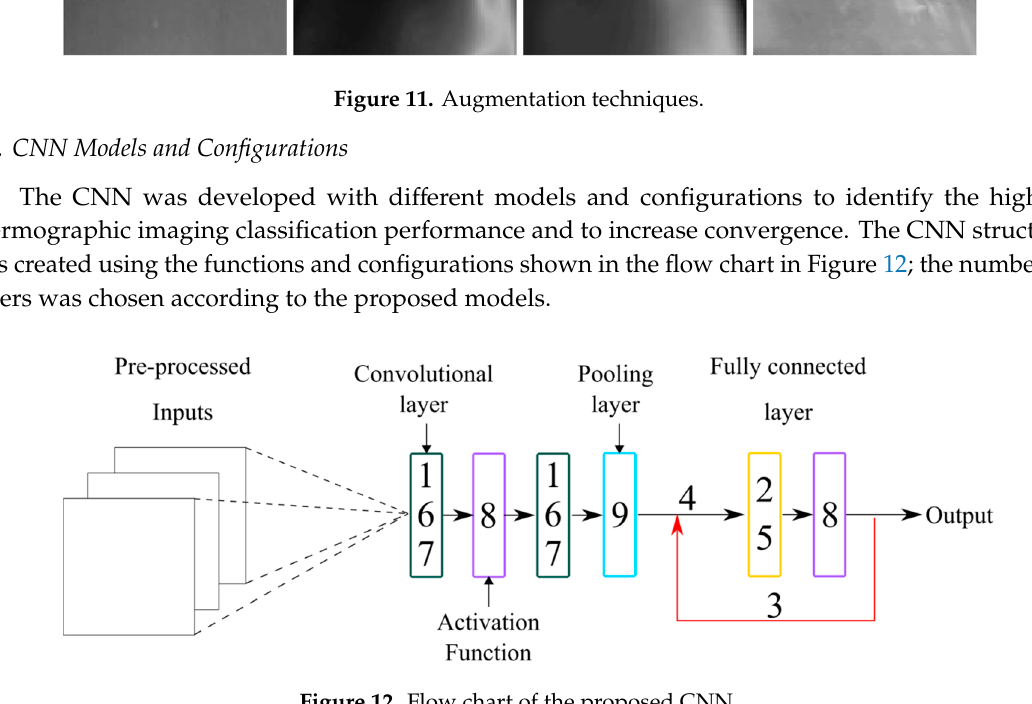
Figure 12. Flow chart of the proposed CNN.